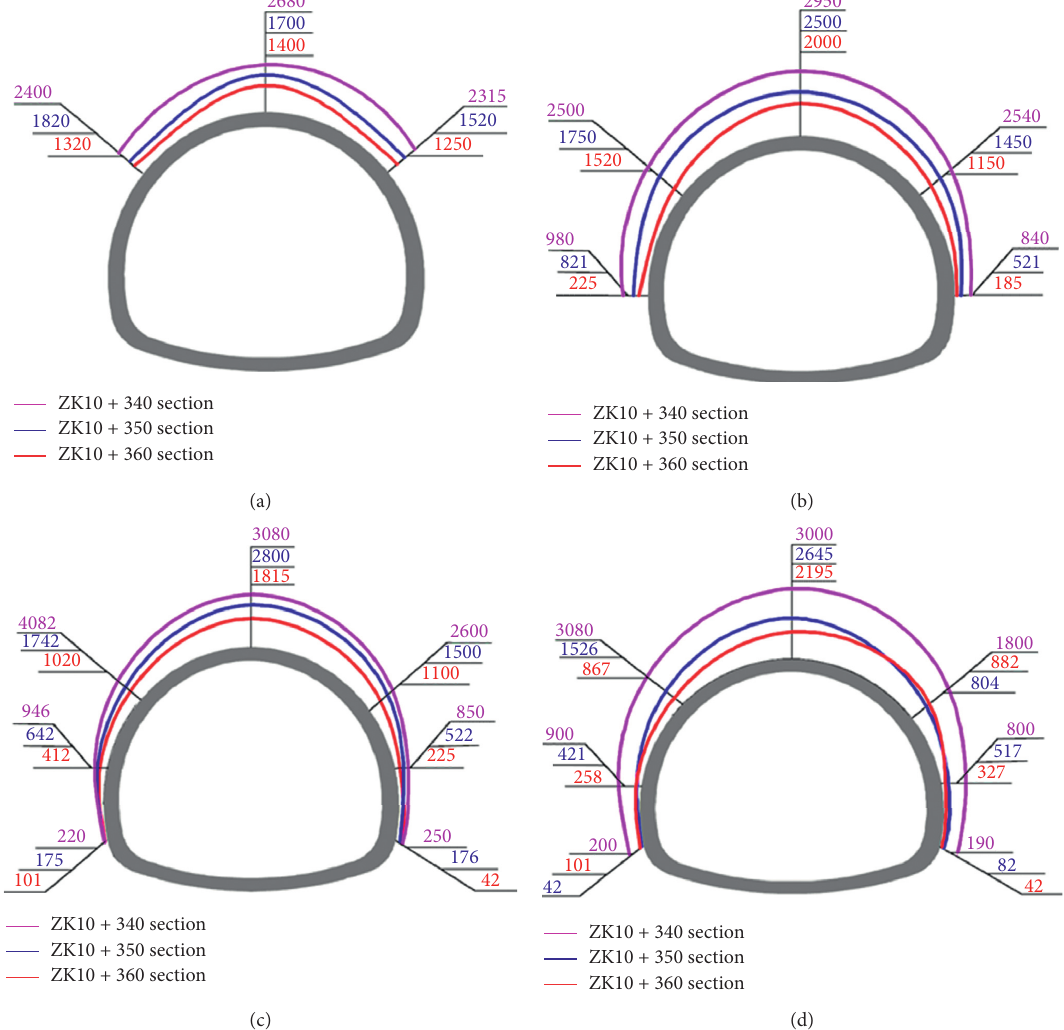
Figure 19: The strain of concrete of three test sections: (a) after the upper step excavation (unit: με ); (b) after the middle step excavation (unit: με ); (c) after the lower step excavation (unit: με ); (d) after stabilization (unit: με